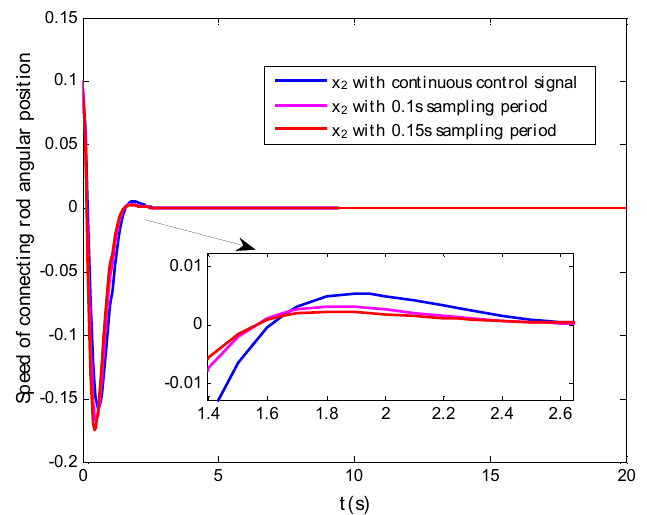
x with different sampling periods.